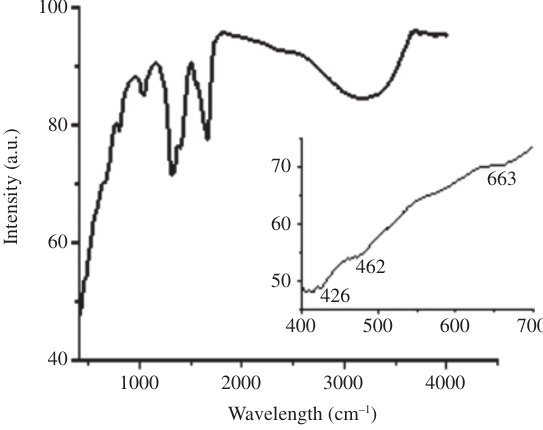
Figure 7: Infrared spectra of iron oxide nanoparticles.